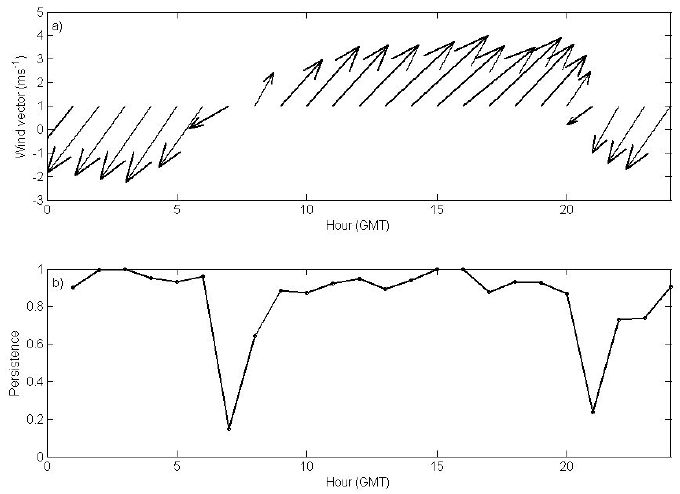
Fig. 6. (a) Diurnal cycle of the near-surface wind vector of the “representative day”, during the summer season at the Assergi site, as predicted by the Mesoscale Model 5. (b) Diurnal variation of wind persistence relative to the wind vector in the upper panel.